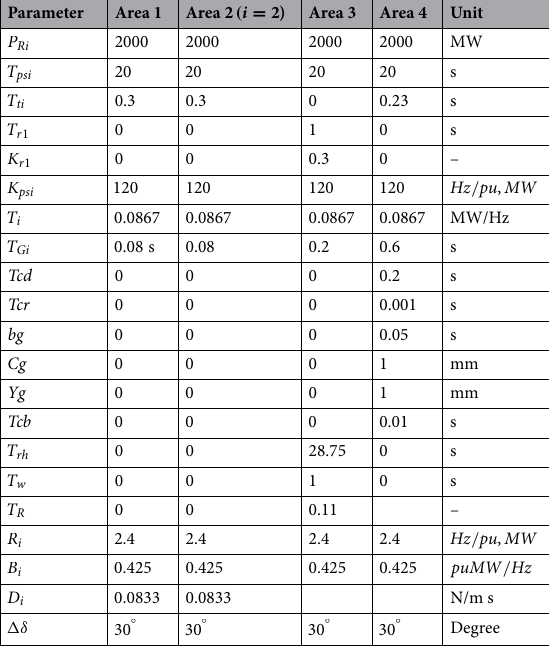
Table 1. The parameters of the four-area power systems 43–45